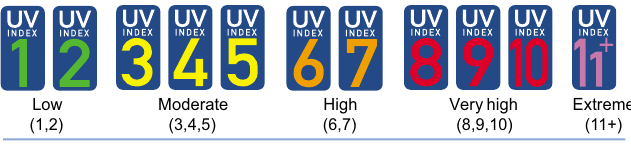
Figure 1. UV radiation exposure categories and International colour codes. Figure extracted from